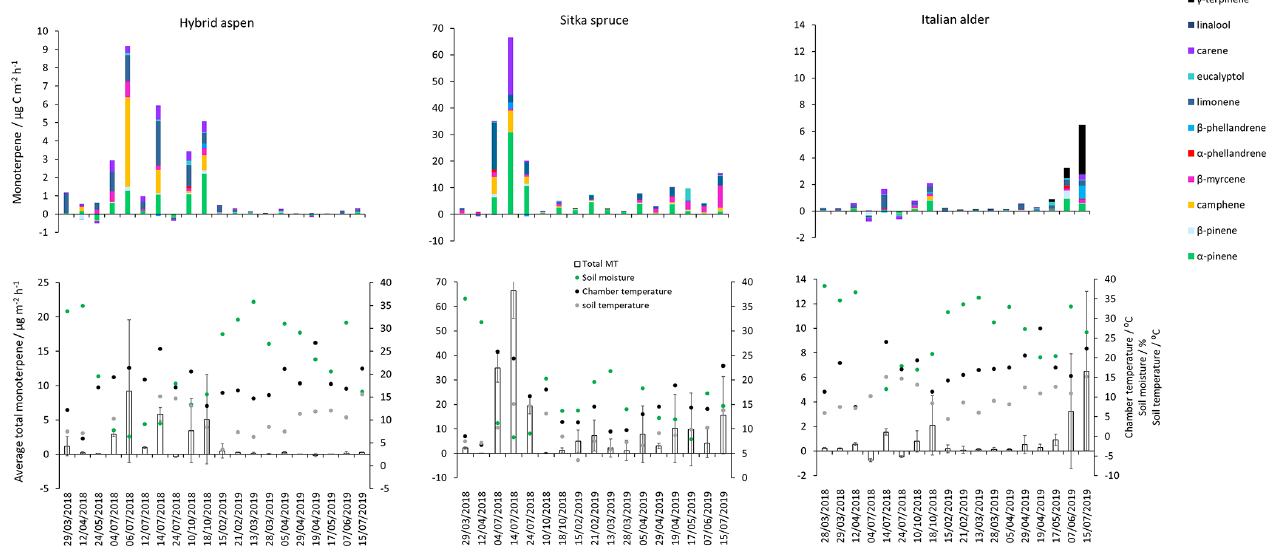
Figure 3. Daily mean measured forest floor total monoterpene emissions from Sitka spruce, hybrid aspen and Italian alder SRF plots at East Grange, Fife, during 2018–2019. Error bars represent the standard deviation of three forest floor chamber measurements. Green circles are volumetric soil moisture (%), black circles are chamber temperature ( ◦ C) and grey circles are soil temperature ( ◦ C). Note that emission scales differ between tree species